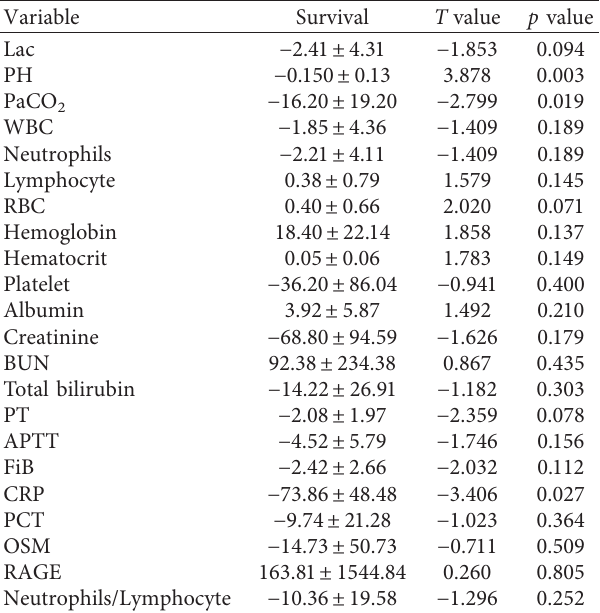
Table 8: Laboratory examination results before and after one-week treatment in the nonsurvival group.